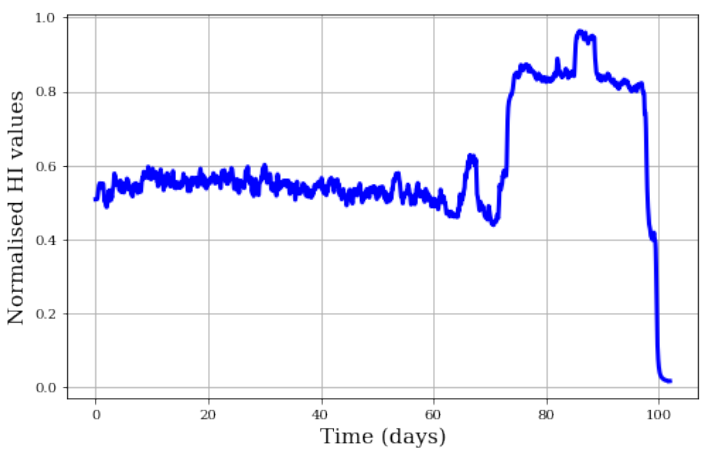
Figure 7. Training process of SAE over 100 iterations.